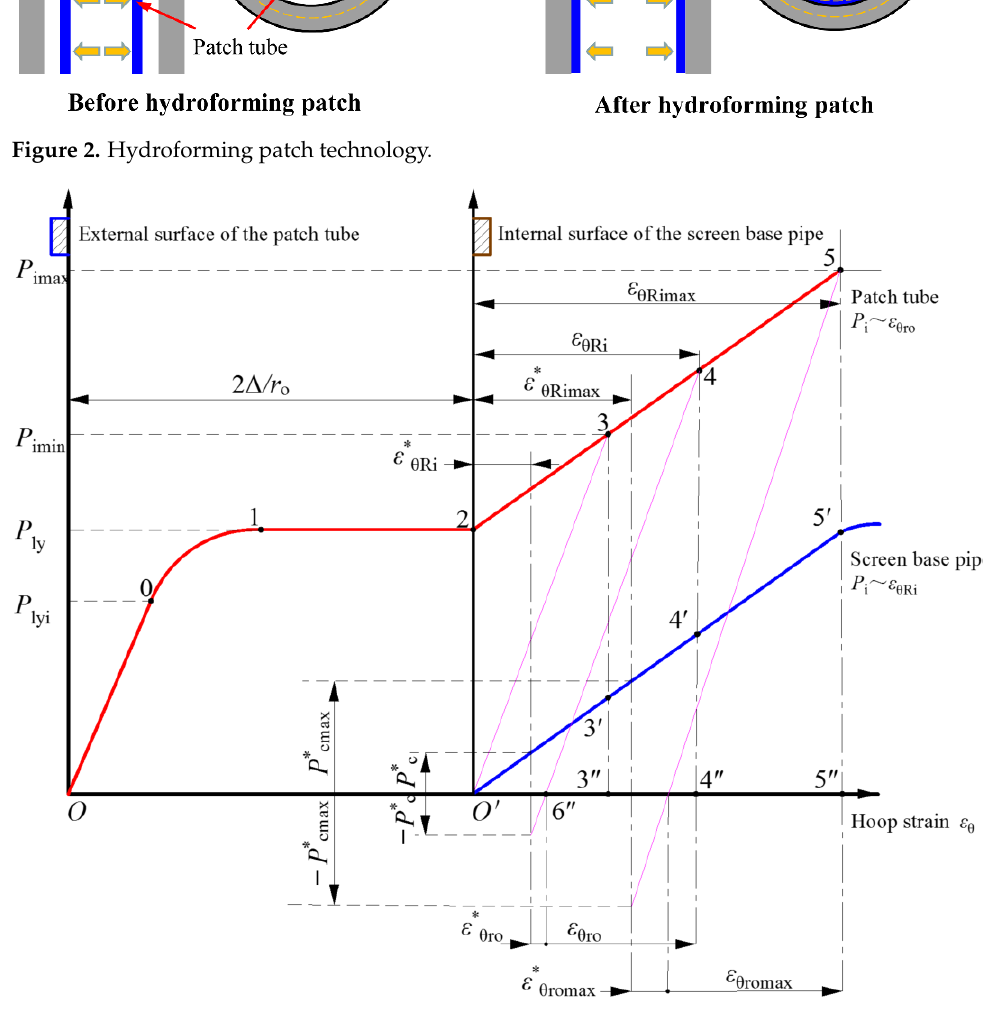
Figure 3. Hydroforming patch of patch tube and screen pipe.